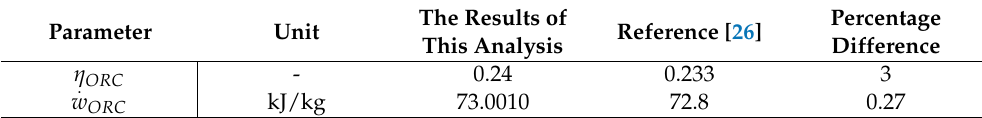
Table 6. Validation results for ORC (for R141b organic fluid).